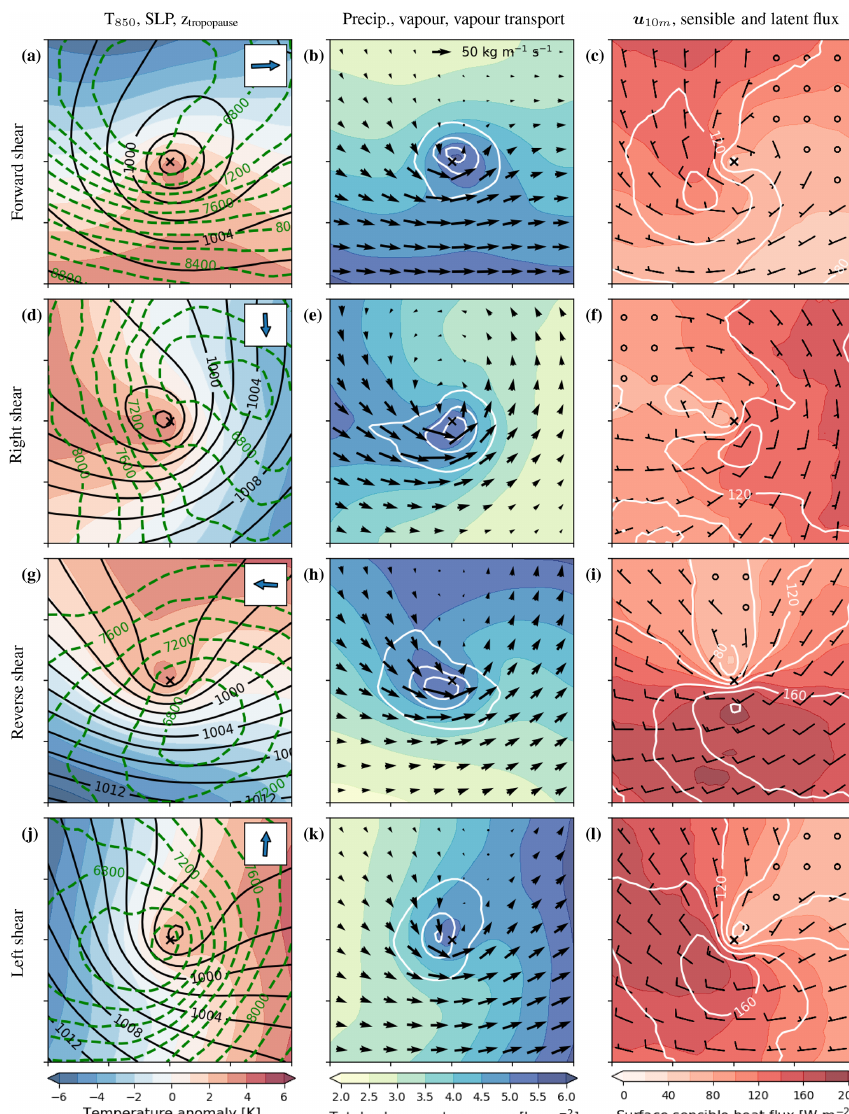
Figure 8. Composite maps on a PL-centred grid with propagation direction towards the right associated with the four strong-shear categories. Left column: temperature anomaly at 850hPa (shading), sea-level pressure (black contours, 2hPa spacing), and tropopause height (green- dashed contours, spacing 200m). The inset shows the mean of the vertical-shear vector within the category (compare to Fig. 4). Middle column: total column water vapour (shading), total precipitation (contours, 0.2mmh − 1 spacing), and vertically integrated water vapour flux (arrow, reference vector in b ). Right column: 10m wind vectors (quivers), surface sensible heat flux (shading), and surface latent heat flux (contours, spacing 20Wm − 2